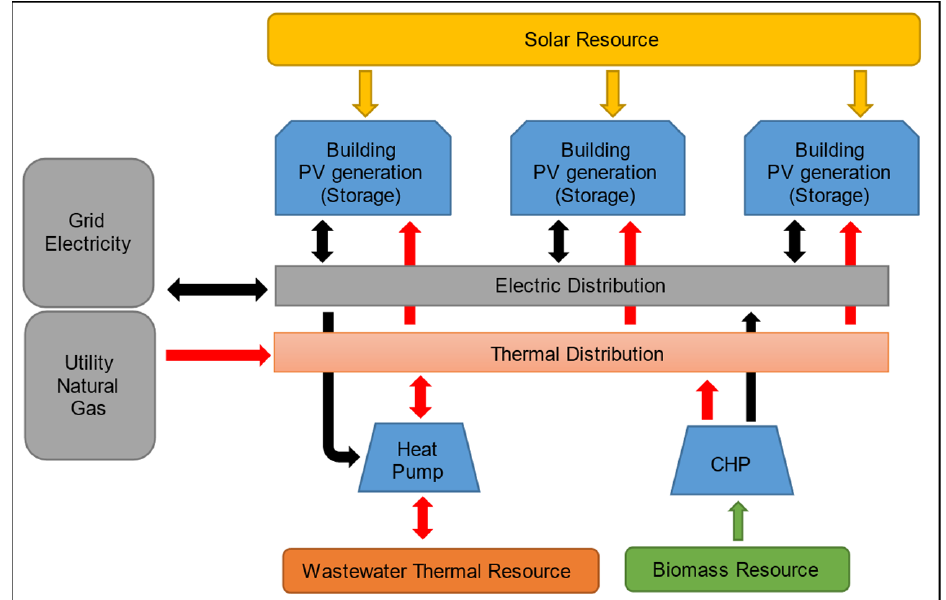
Figure 1. Technical-logical schematic for the load/generation analysis. Arrows indicate direction of (or bi-directional) flow of energy resources as well as electricity (black) and heat (red). The analysis assumes the presence of electric and thermal distribution systems to distribute electricity to and from buildings, as well as distribute heat to and from the wastewater thermal resource via the heat pump. Electricity flow with the grid is bi-directional (can be exported), but useful heat energy cannot be exported from the